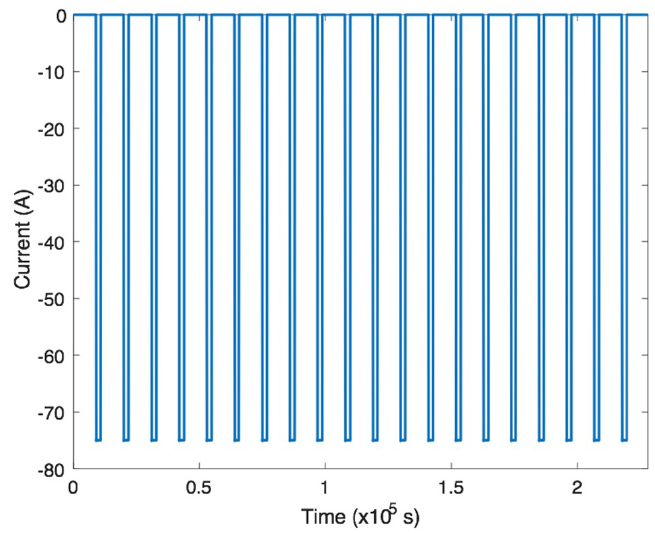
Figure 2. The battery pulse test profile.